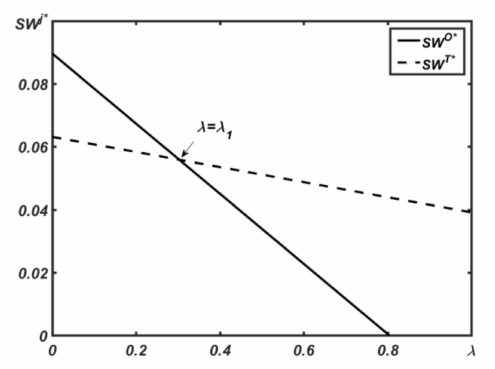
Figure 7. Variations of SW j ∗